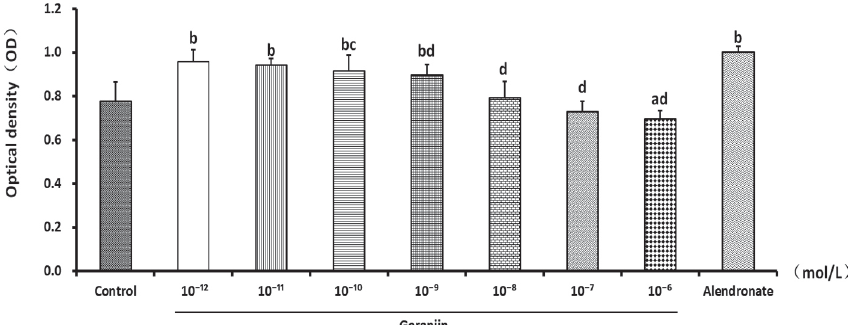
FIGURE 2 - Effects of geraniin on proliferation of osteoblasts. Values are mean ± S.D. ( n =6) a P < 0.05, b P < 0.01 versus control group, c P < 0.05, d P < 0.01 versus alendronate group.